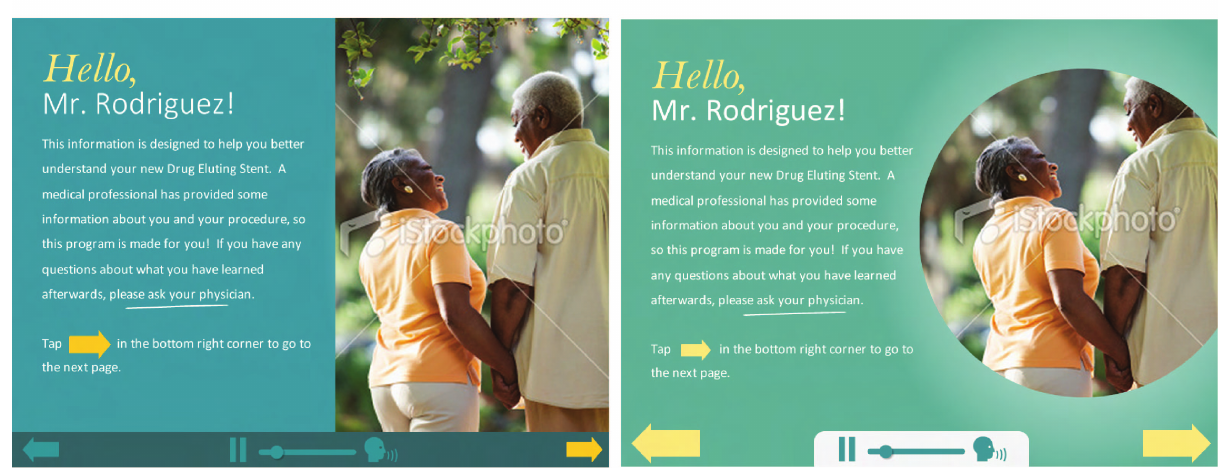
Figure 5. Color design concepts of the My Interventional Drug-Eluting Stent Educational App: (A) Concept 3 and (B) Concept 4.